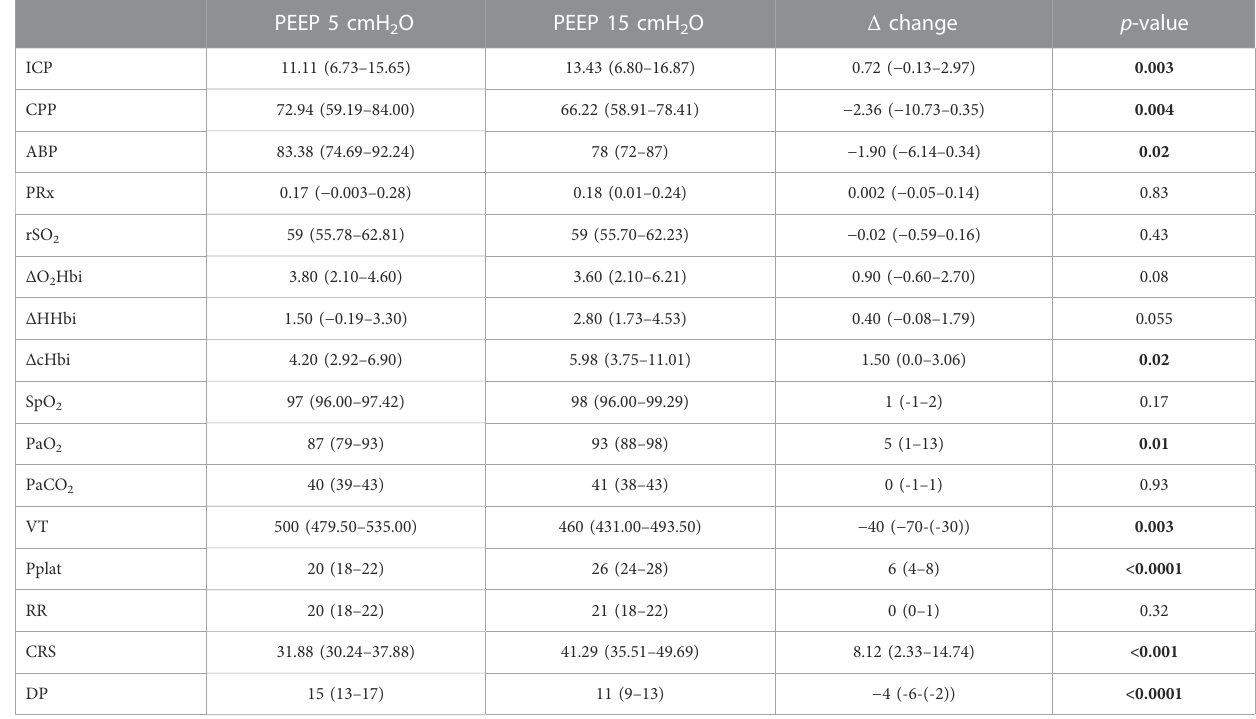
TABLE 2 Neuromonitoring and systemic parameters at baseline (PEEP 5 cmH 2 O) and post-PEEP test (PEEP 15 cmH 2 O) (median (interquartile range)).